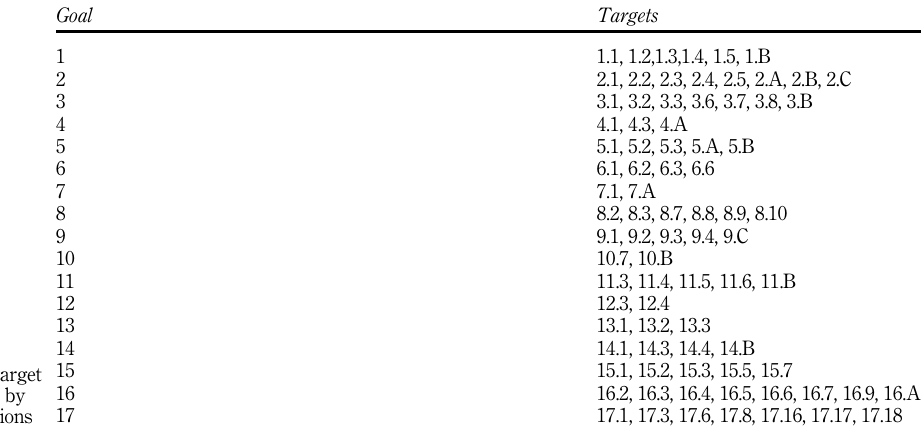
Table 1. NumberofSDGstarget partially attended by the public